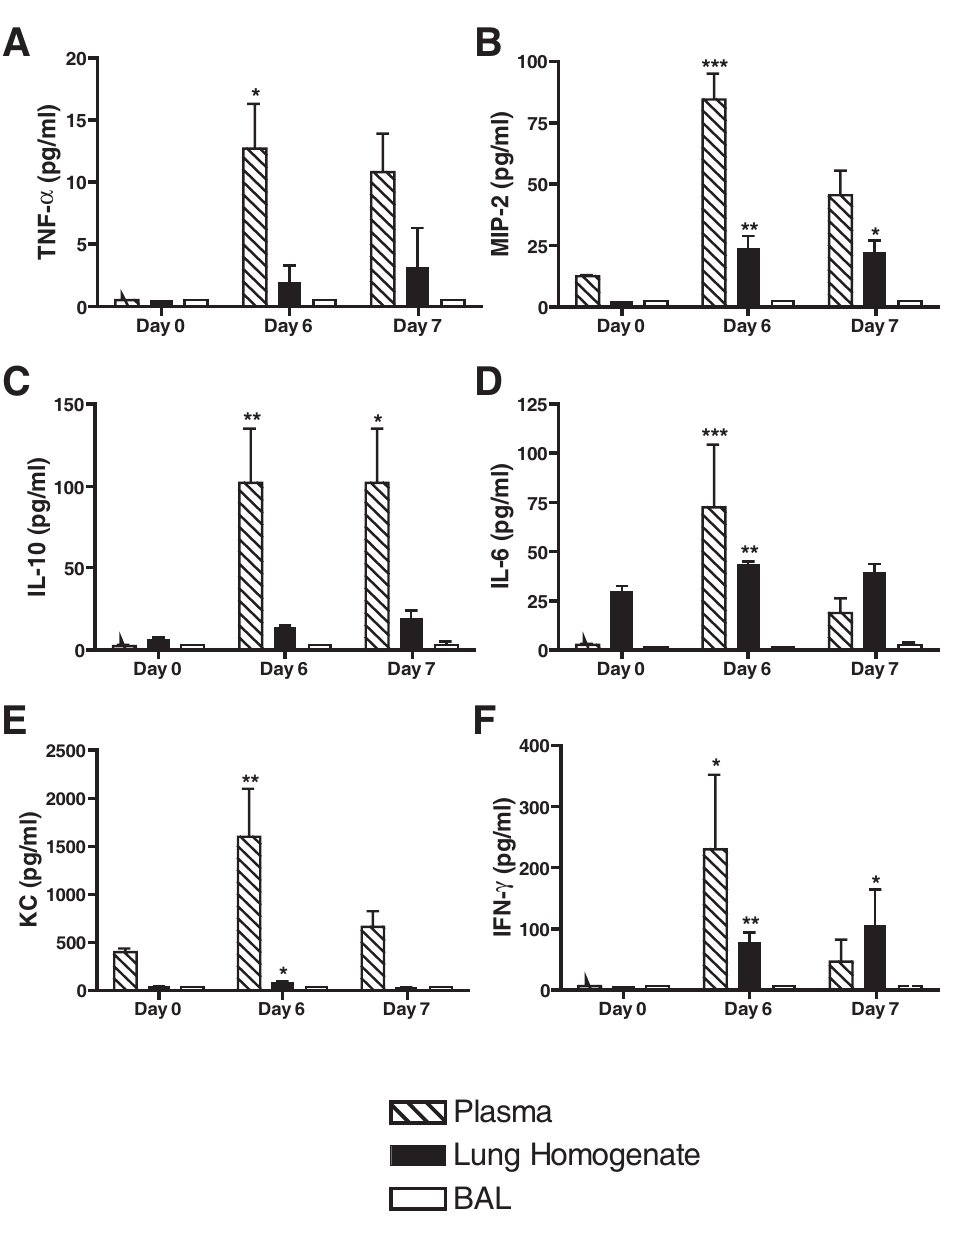
Figure 2. Cytokines and chemokines are not present in the BALF of PbA-infected C57BL/6 mice. A panel of cytokines and chemokines was examined in the plasma, lung homogenate and BALF of uninfected and PbA infected C57BL/6 mice (n=6/group/experiment, representative of two independent experiments, expressed as mean + / 2 SEM). All cytokines/chemokines examined were elevated at D6 compared to baseline (Kruskal-Wallis test with Dunn’s multiple comparison test; * p , 0.05, **p , 0.01, and ***p , 0.001; TNF ( A ), MIP2 ( B ), IL-10 ( C ), IL-6 ( D ), KC ( E ) and IFN- c ( F )). IL-6 and KC were elevated in lung homogenates at day 6 versus day 0, and MIP-2 and IFN- c levels were increased at both days 6 and 7 post- infection (Kruskal-Wallis test with Dunn’s multiple comparison test; * p , 0.05, **p , 0.01, and ***p , 0.001). TNF and IL-10 levels in lung homogenate fell below the detection range of the assay. Notably, none of the cytokines were detectable in the BALF, indicating that inflammation occurs peripherally and in the lung tissue, but not in the alveolar